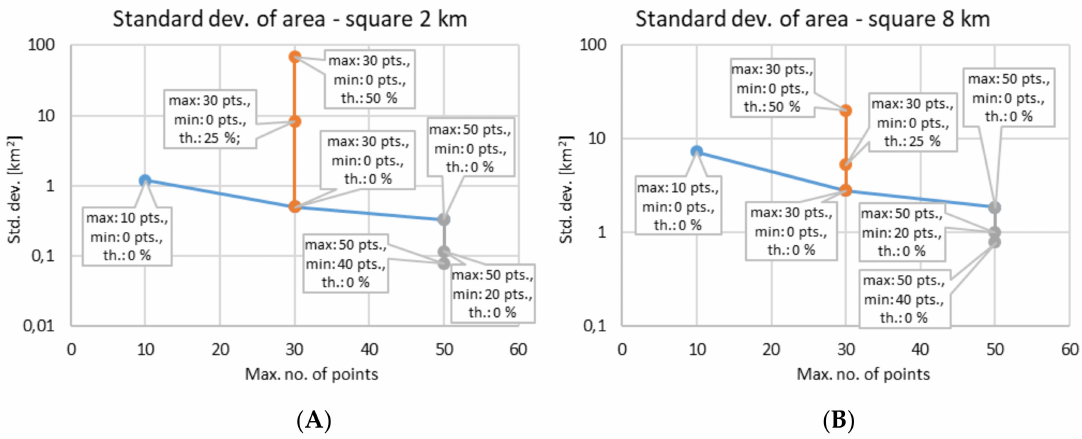
Figure 10. Diagrams of the changes in the standard deviation of the primary field surface area for squares: ( A )—2 × 2 km, ( B )—8 × 8